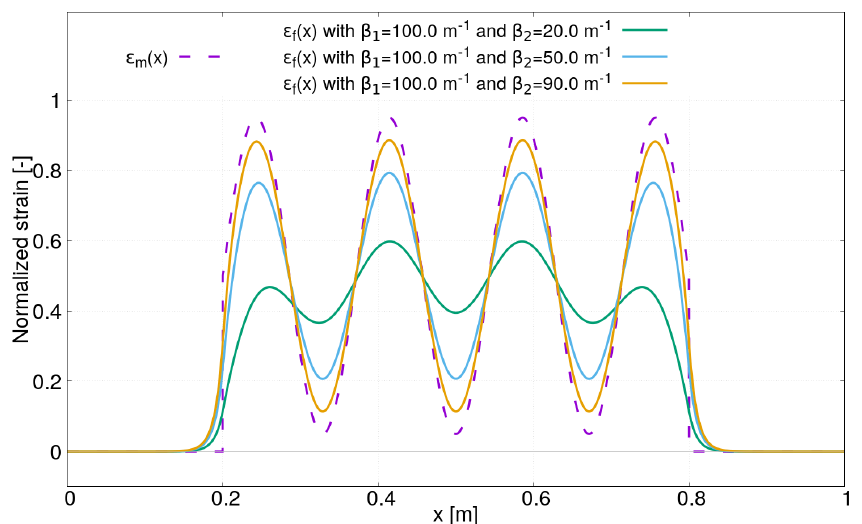
Figure 6. Strain distribution in the core of optical fiber sensor (cid:101) f ( x ) induced by a sine strain field (cid:101) m ( x ) in the host